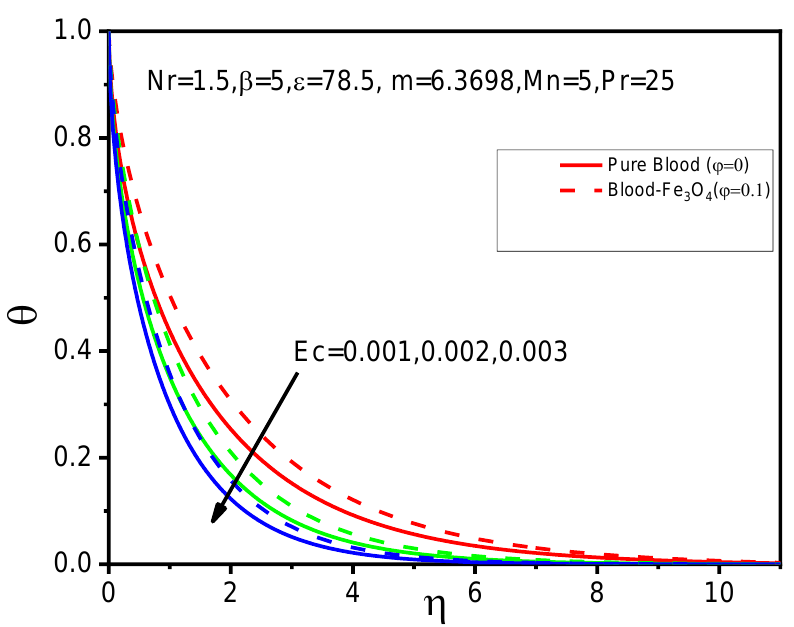
 . Figure 16. (Case a): Variations of θ for Ec = 0.001, 0.002, 0.003 against η .